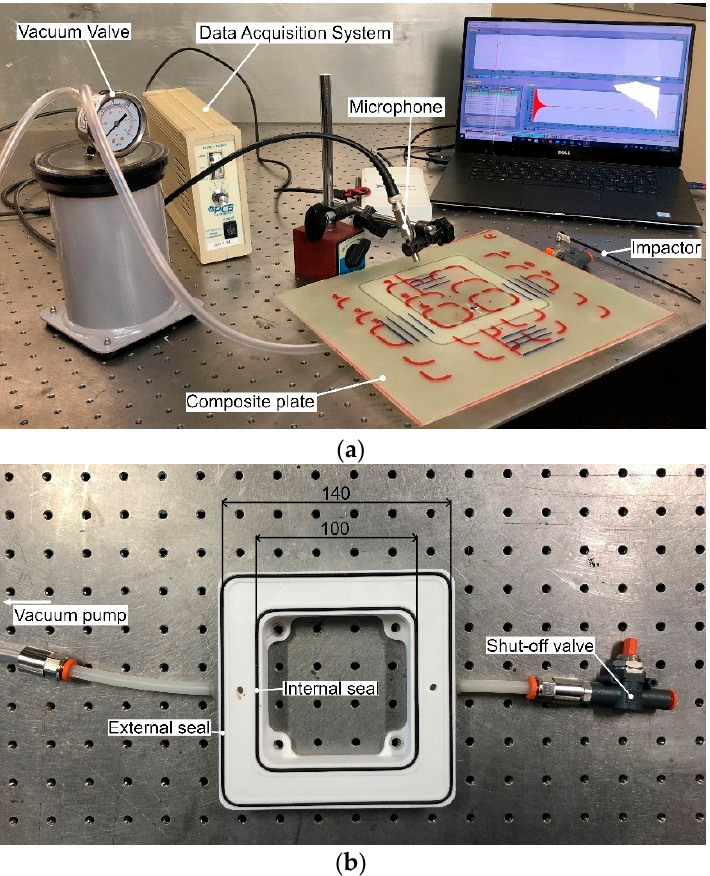
Figure 4. Experimental setup ( a ) and clamping device ( b ) of the local vibrational analysis